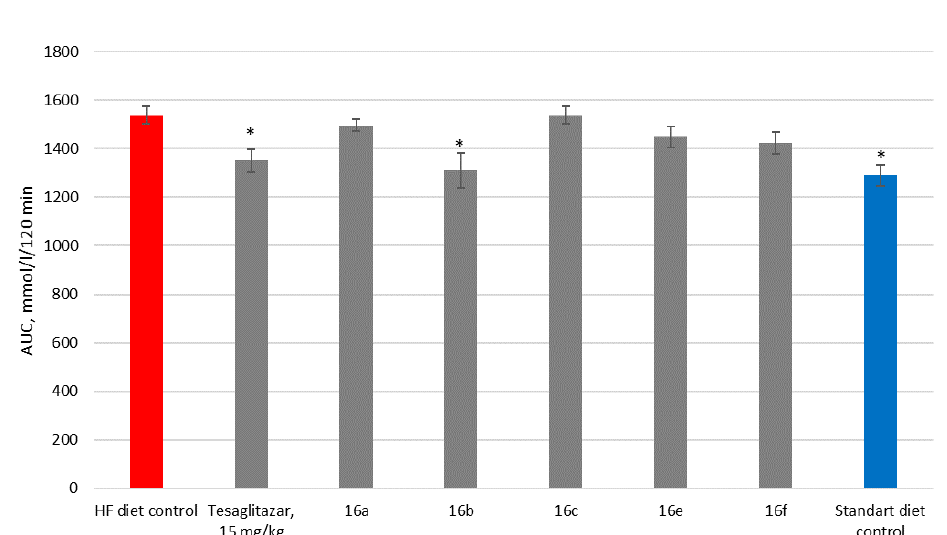
Figure 4. Oral glucose tolerance test results. 16a–f were introduced at a dose of 30 mg/kg. * p < 0.05 compare to HF diet control.